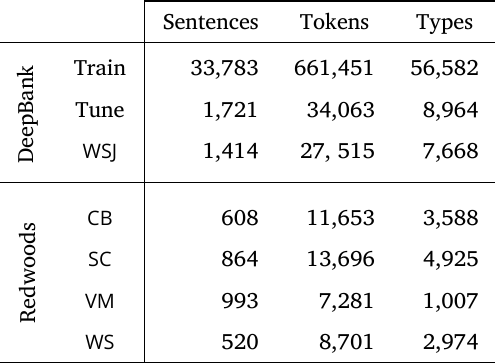
Sentence, token, and type counts for data